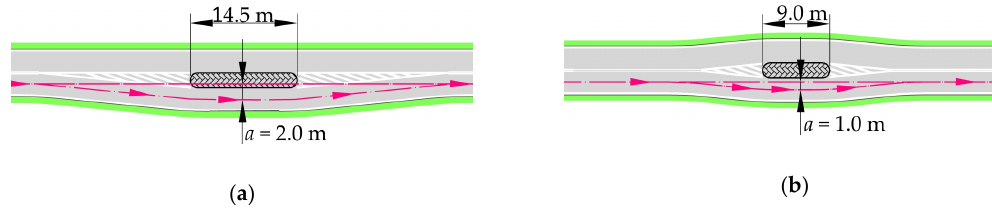
Figure 14. Types of road chicanes provided in village entry transition zones and the resulting horizontal deflection of the travel lane from the straight line a : ( a ) central island providing horizontal deflection of one lane – a = 2 m; ( b ) central island providing horizontal deflection of both lanes – a = 1 m.